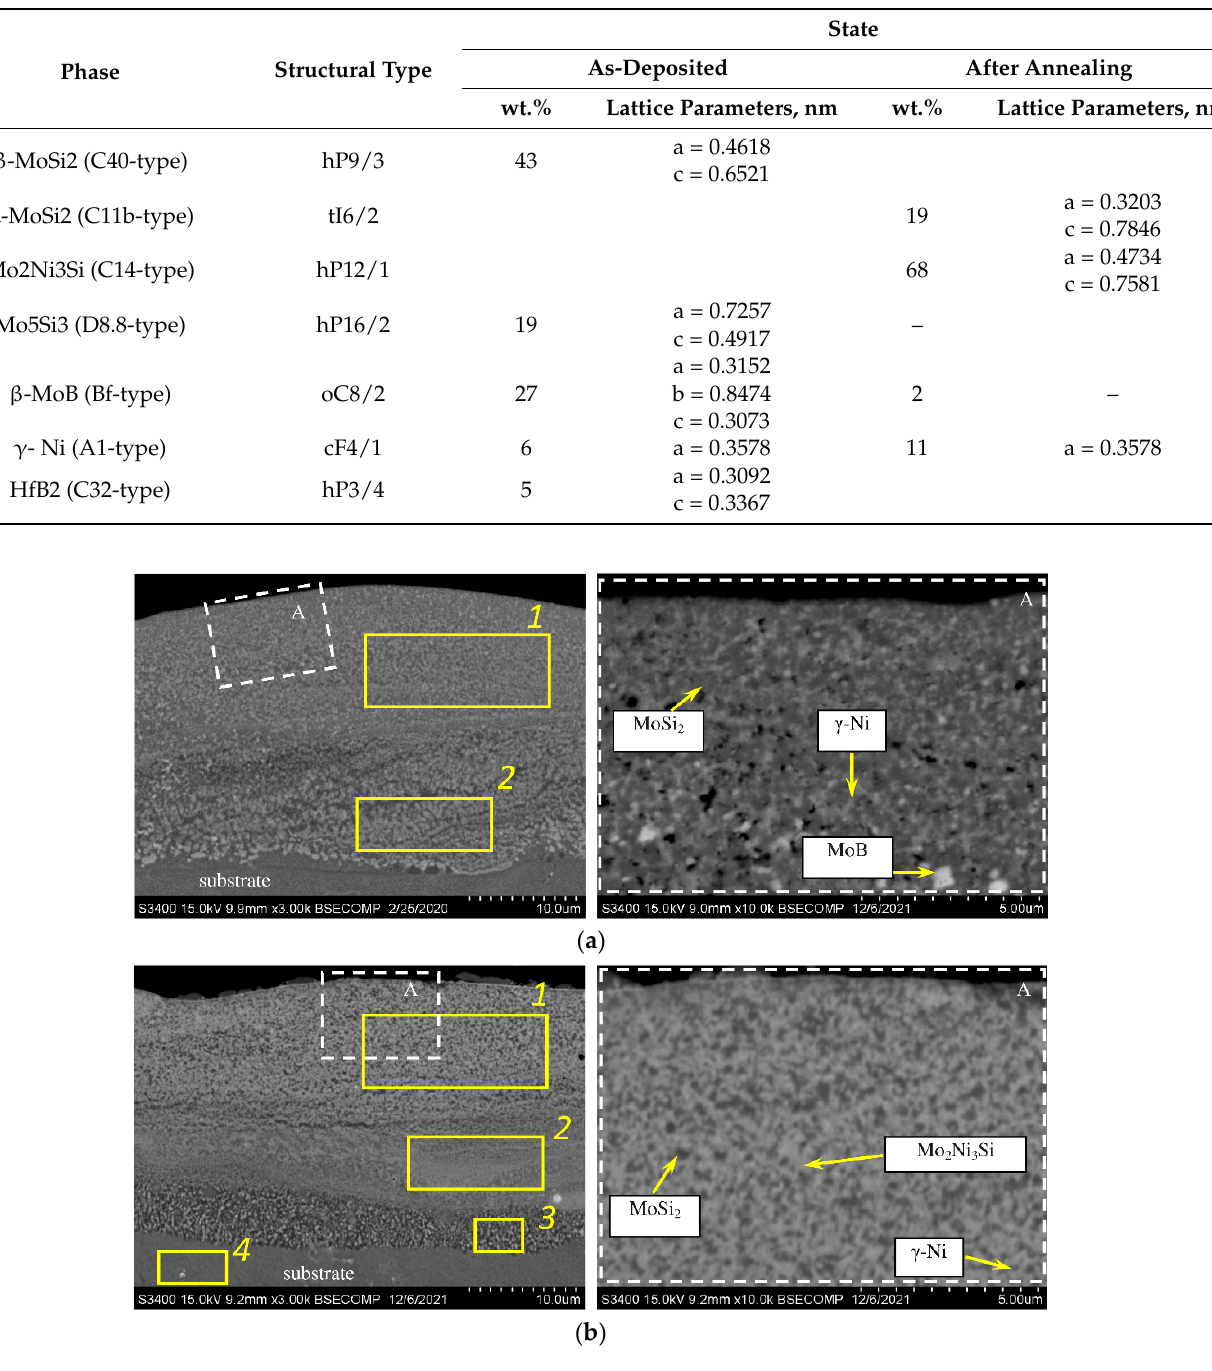
Table 2. EDS data for the coatings produced using the MoSi 2 –MoB–HfB 2 electrode before and after annealing (Figure 2).